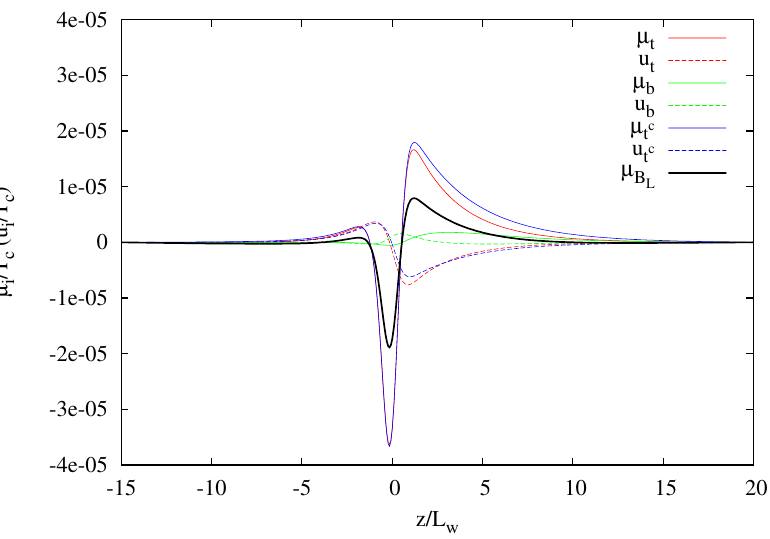
Figure 4 . An example of solutions to the transport equations and its obtained left-handed baryon chemical potential (cid:22) B as functions of the coordinate z transverse to the bubble wall. All of the L chemical potentials (cid:22) i and velocities u i are noralized with respect to the critical temperature T c , while the coordinate z is normalized with respect to the bubble wall width L w . The corresponding parameters are v c = 155 : 9 GeV, w c = 525 : 3 GeV, (cid:11) = (cid:0) 1 : 225, T c = 93 : 85 GeV, L w T c = 5 : 111 and (cid:3) = 1131 GeV, which can give the observed baryon asymmetry.